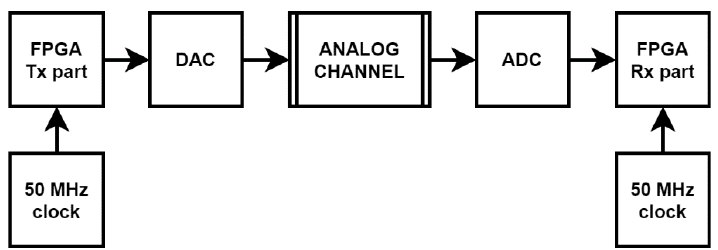
Figure 7. The general structure of the prototype setup.